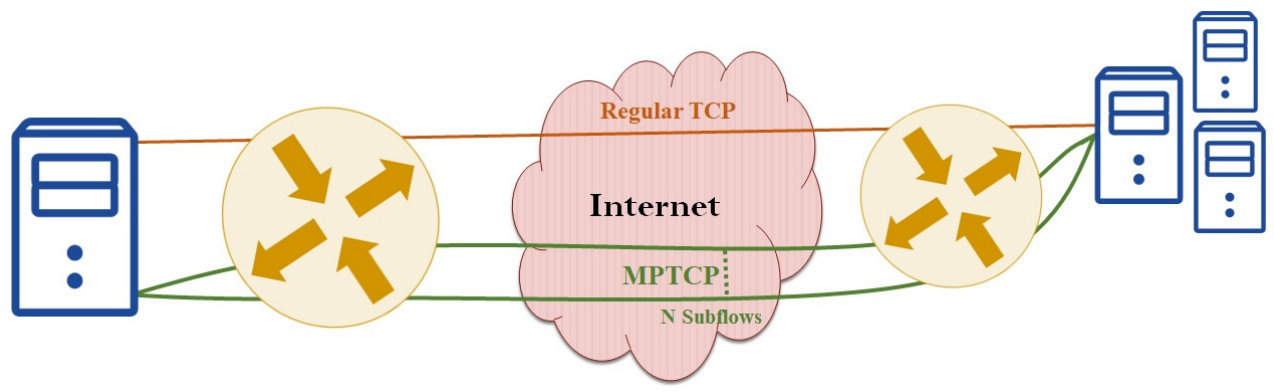
Figure 1. MPTCP and TCP connection.